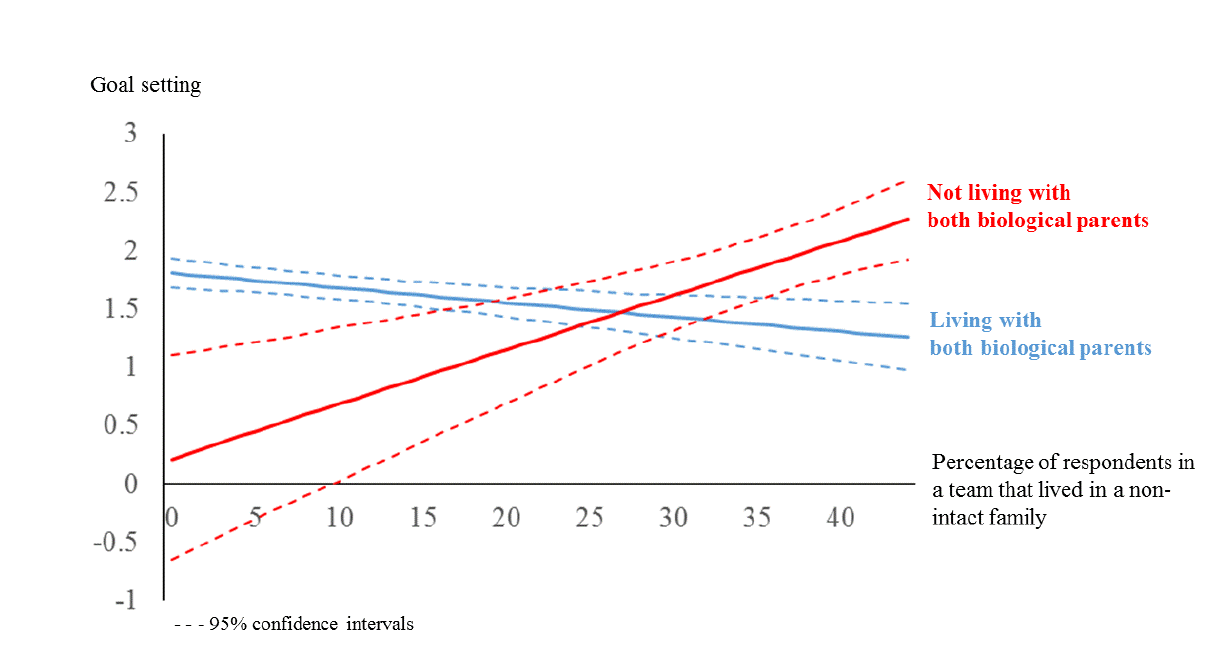
Figure 1 . Interaction effect for goal setting between the respondents’ family structures on the participant and team